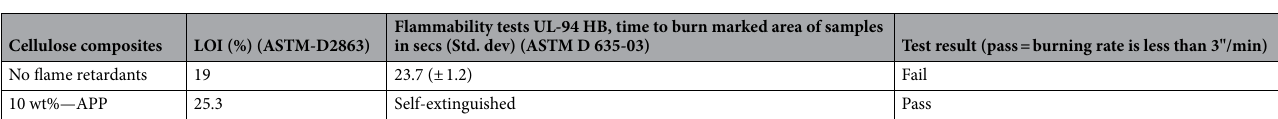
Table 1. Effect of addition of APP on the limited oxygen index and flammability of the cellulose.